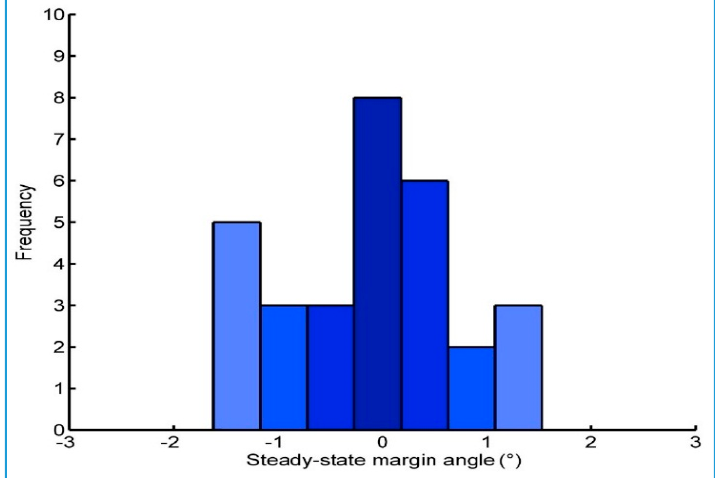
Figure 16. SSMA distribution map (30 groups of static tests).